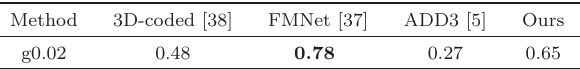
Table 2 Comparison of the proposed method to deep learning-based shape correspondence methods on the Scape dataset Method